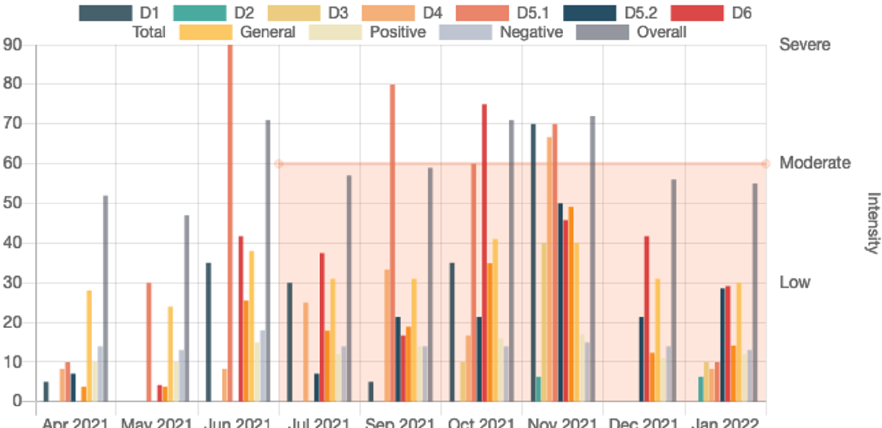
Figure 5. Visualization of two psychopathological scales (WHODAS II and PANSS), along with one moderate relapse shown in the orange opaque box. D1-D6 and Total refers to WHODAS II, whereas General, Positive, Negative and Overall to